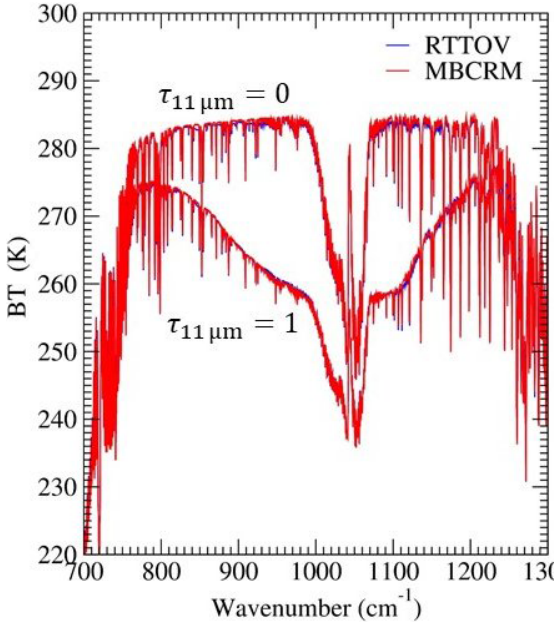
Figure 2. Comparisons of the IASI BTS simulated using MBCRM and RTTOV (version 12.2) for clear-sky ( τ 11µm = 0) and cloudy ( τ 11µm = 1) atmosphere. Optical depth was defined as that at wave- length 11µm ( ν = 907 . 488cm − 1 ). The average atmospheric profile in the ECMWF 52 diverse profile dataset (no. 52) and the satellite zenith angle 0 ◦ were used, and a sea surface emissivity model and surface temperature 286.52K were applied. For cloudy atmosphere, a homogeneous aerosol layer between 358.966 and 459.712hPa, and the aerosol properties of the “new volcanic ash (VAPO)” model in RTTOV (Vidot and Hocking, 2017) were considered. For RT- TOV, result of the eight-stream discrete-ordinate method (DOM) was plotted. For MBCRM calculations, we read the complex re- fractive index (RI) data of VAPO from the figure in the RTTOV-11 Science and Validation Report (Saunders et al.,